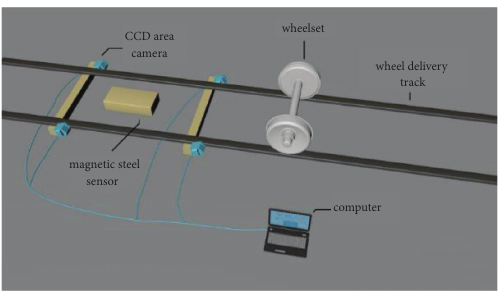
Figure 5: Schematic diagram of wheelset tread defect collection